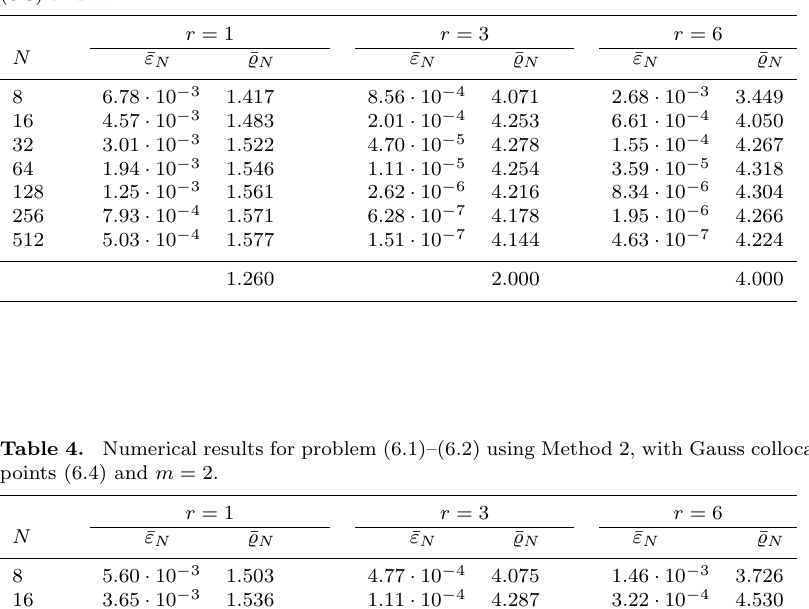
Table 3. Numerical results for problem (6.1)–(6.2) using Method 2, with collocation points (6.3) and m = 2.